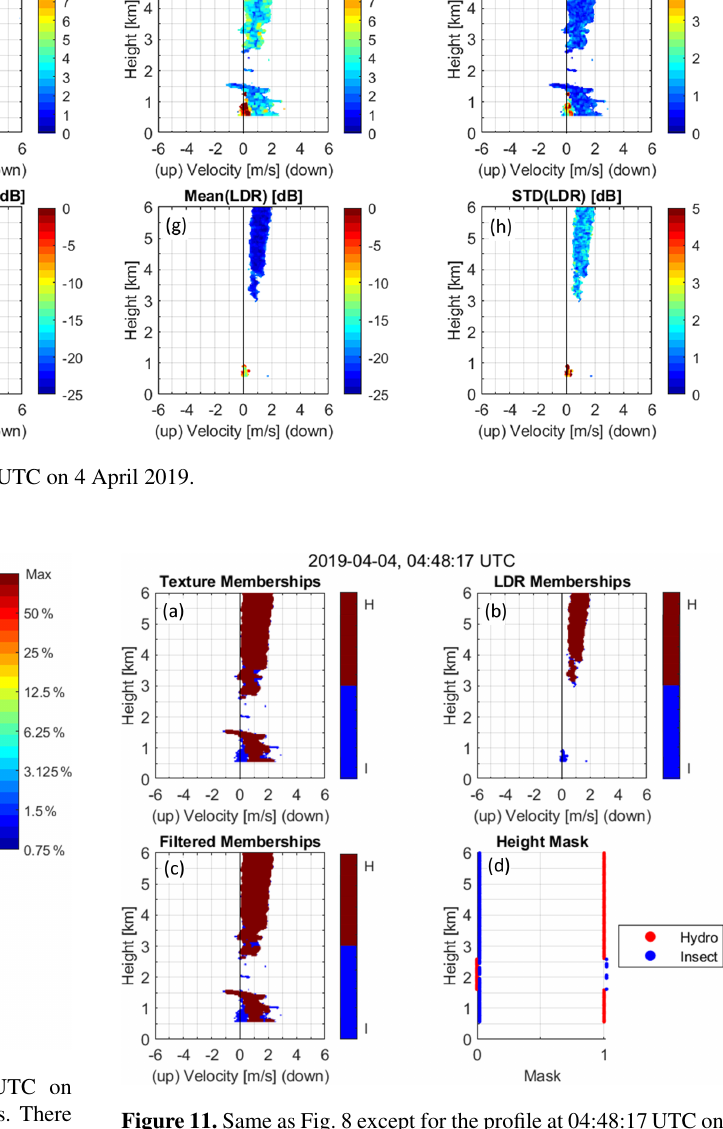
Figure 11. Same as Fig. 8 except for the profile at 04:48:17UTC on 4 April